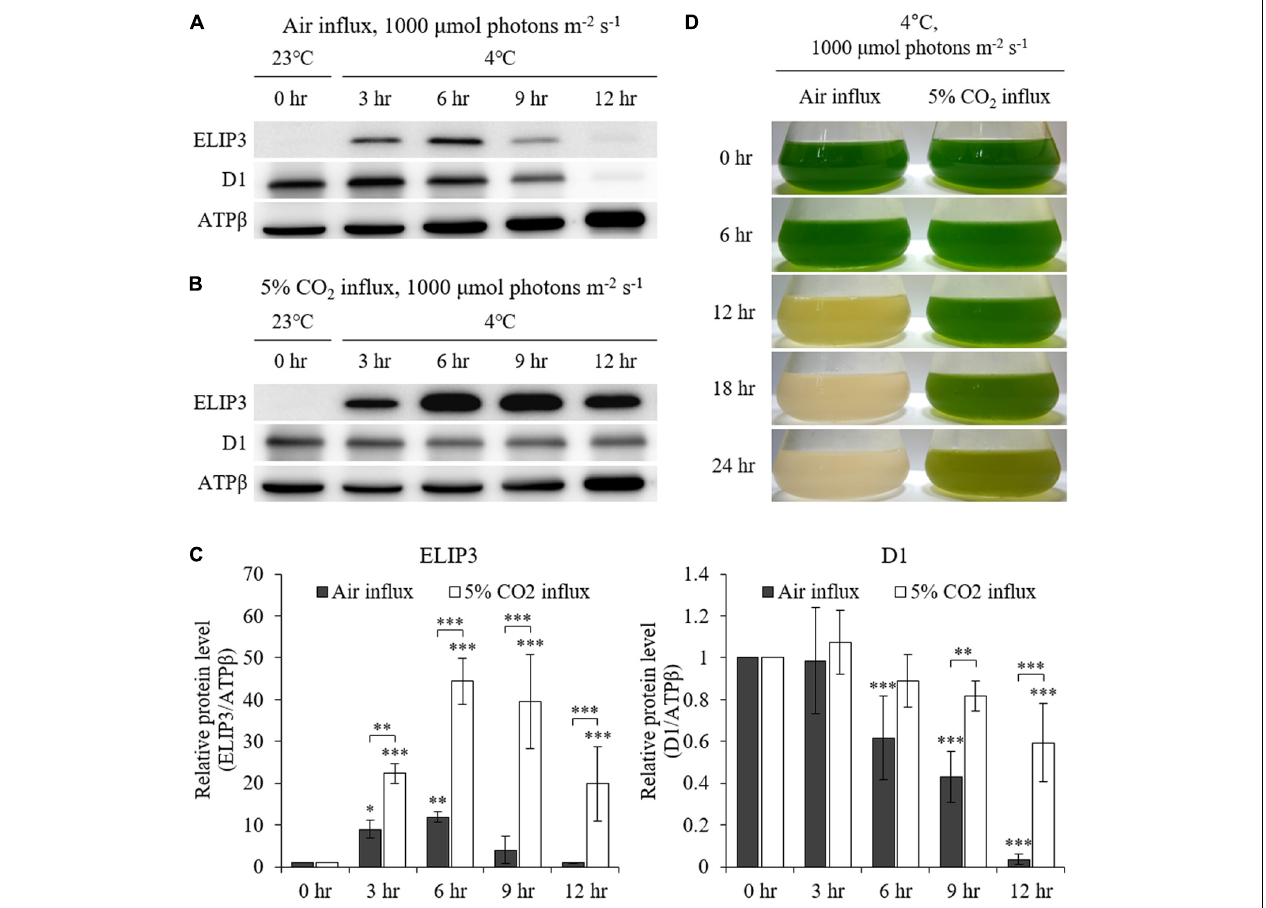
FIGURE 4 | Western blot analysis of C. reinhardtii with 5% CO 2 supply at low temperature (4 ◦ C) and high light (1,000 µ mol photons m − 2 s − 1 ) using a photobioreactor. (A) Accumulation of ELIP3 and D1 in air flux condition. (B) Accumulation of ELIP3 and D1 with 5% CO 2 supply. ATP β was used as a loading control. (C) Densitometry of western blots in (A) and (B) . Data are expressed as mean ± SD (two-way ANOVA with Bonferroni’s multiple comparisons test, n = 3). (D) The response of C. reinhardtii cells to low temperature and high light with or without added CO 2 supply. ∗ P < 0.05, ∗∗ P < 0.01, ∗∗∗ P <